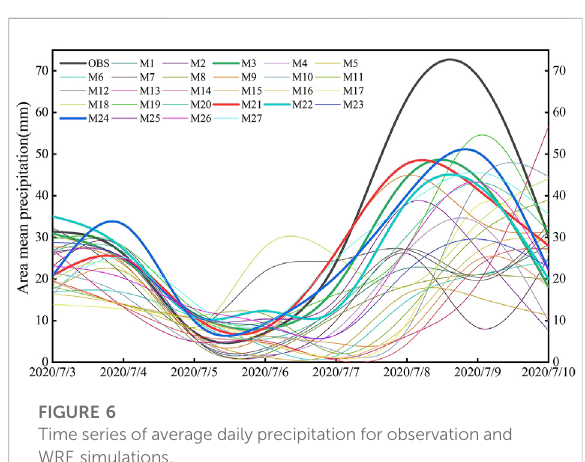
FIGURE 6 Time series of average daily precipitation for observation and WRF